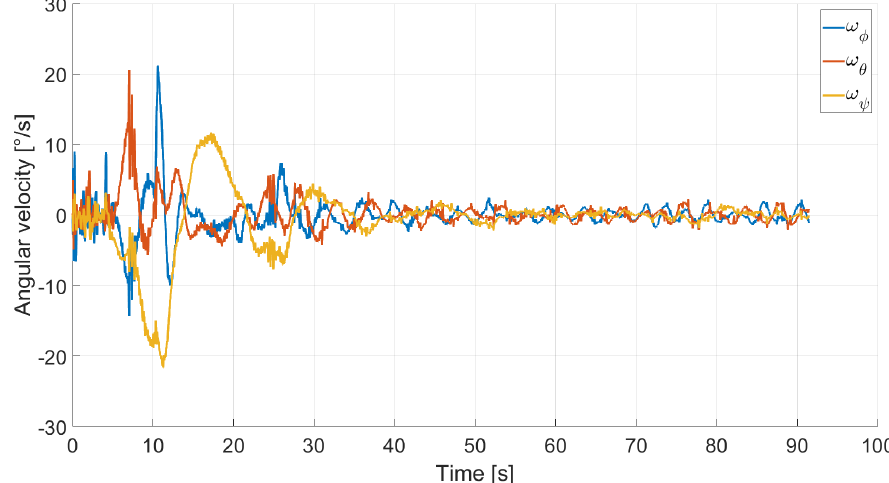
Figure 18. Case 2: angular velocity.